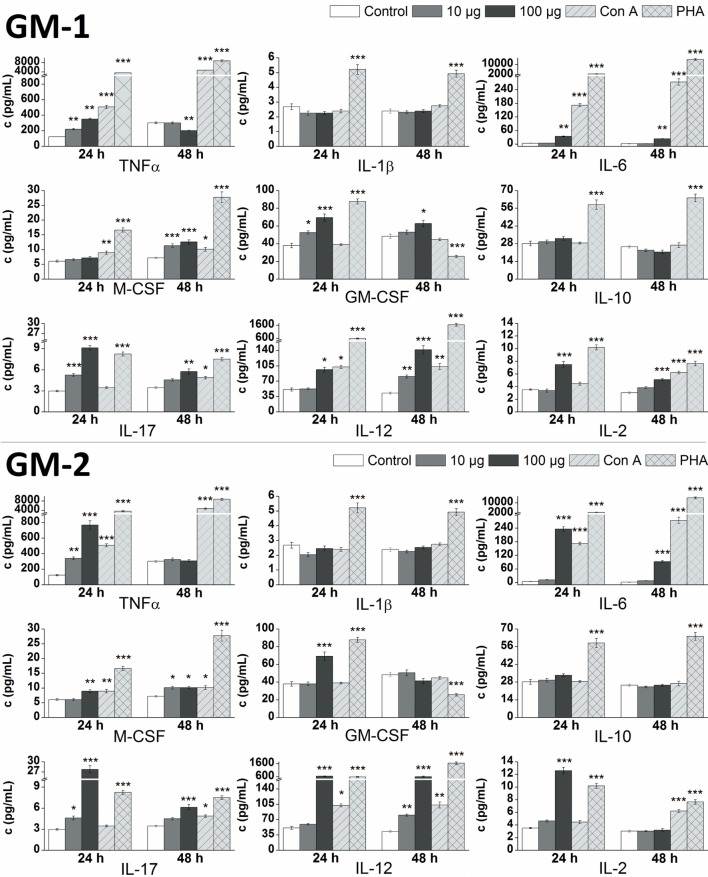
Effect of glycoconjugates GM-1 and GM-2 on RAW 264.7 macrophages cytokines production. Concentrations of cytokines in media after 24- or 48-h stimulation of RAW 264.7 macrophages in response to stimulation with 10 or 100 µg/mL concentration of glycoconjugates GM-1 or GM-2, to positive controls concanavalin A (Con A, 10 µg/mL) and phytohemagglutinin (PHA, 10 µg/mL). Negative control represents untreated RAW 264.7 cells (Control). All data are presented as Mean ± SD. Tests were carried out in triplicate. The statistical significance of differences between stimulated cells and untreated cells using one-way ANOVA and post hoc Bonferroni’s tests is expressed: ***—P < 0.001, **—0.001 < P < 0.01, *—0.01 < P < 0.05.